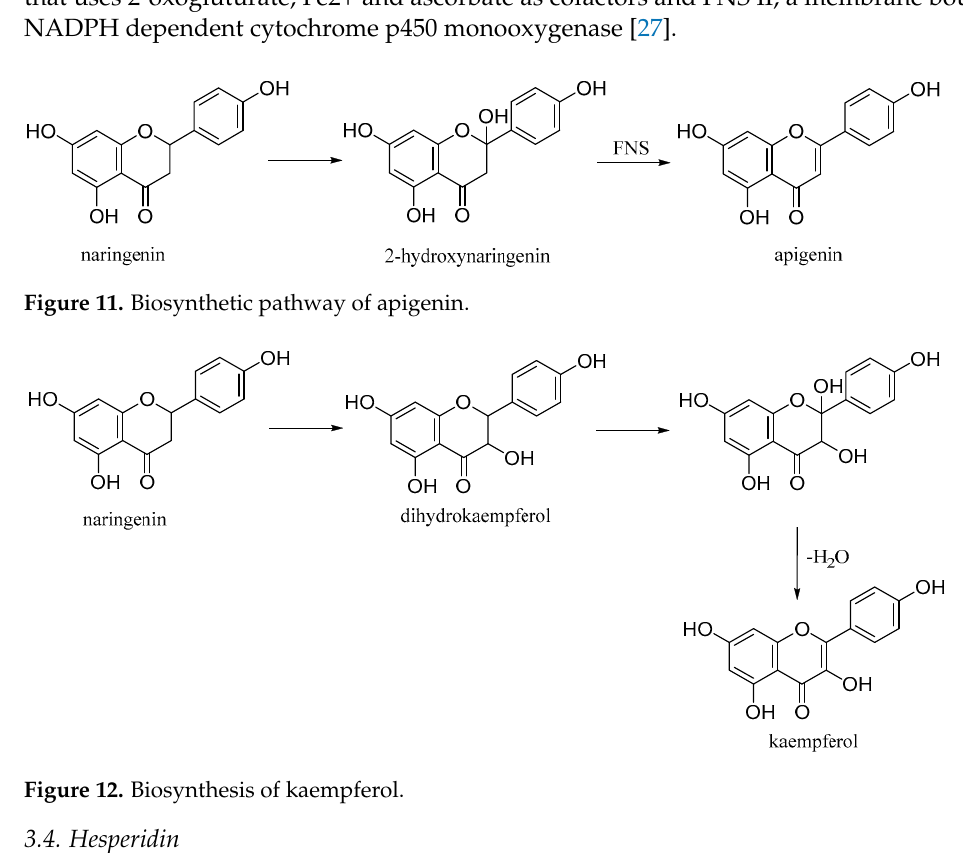
Figure 12. Biosynthesis of kaempferol .